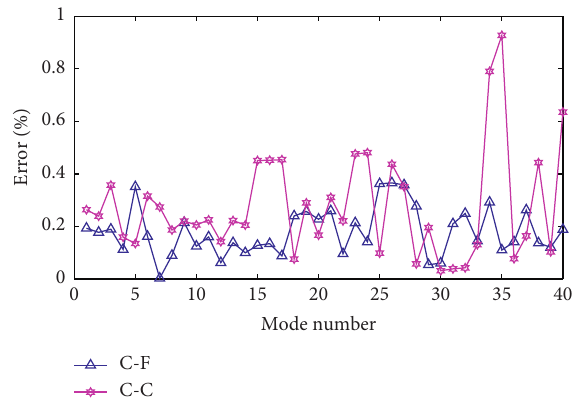
Figure 4: Relative deviation of the frequency of conical shell under C–F and C–C boundary